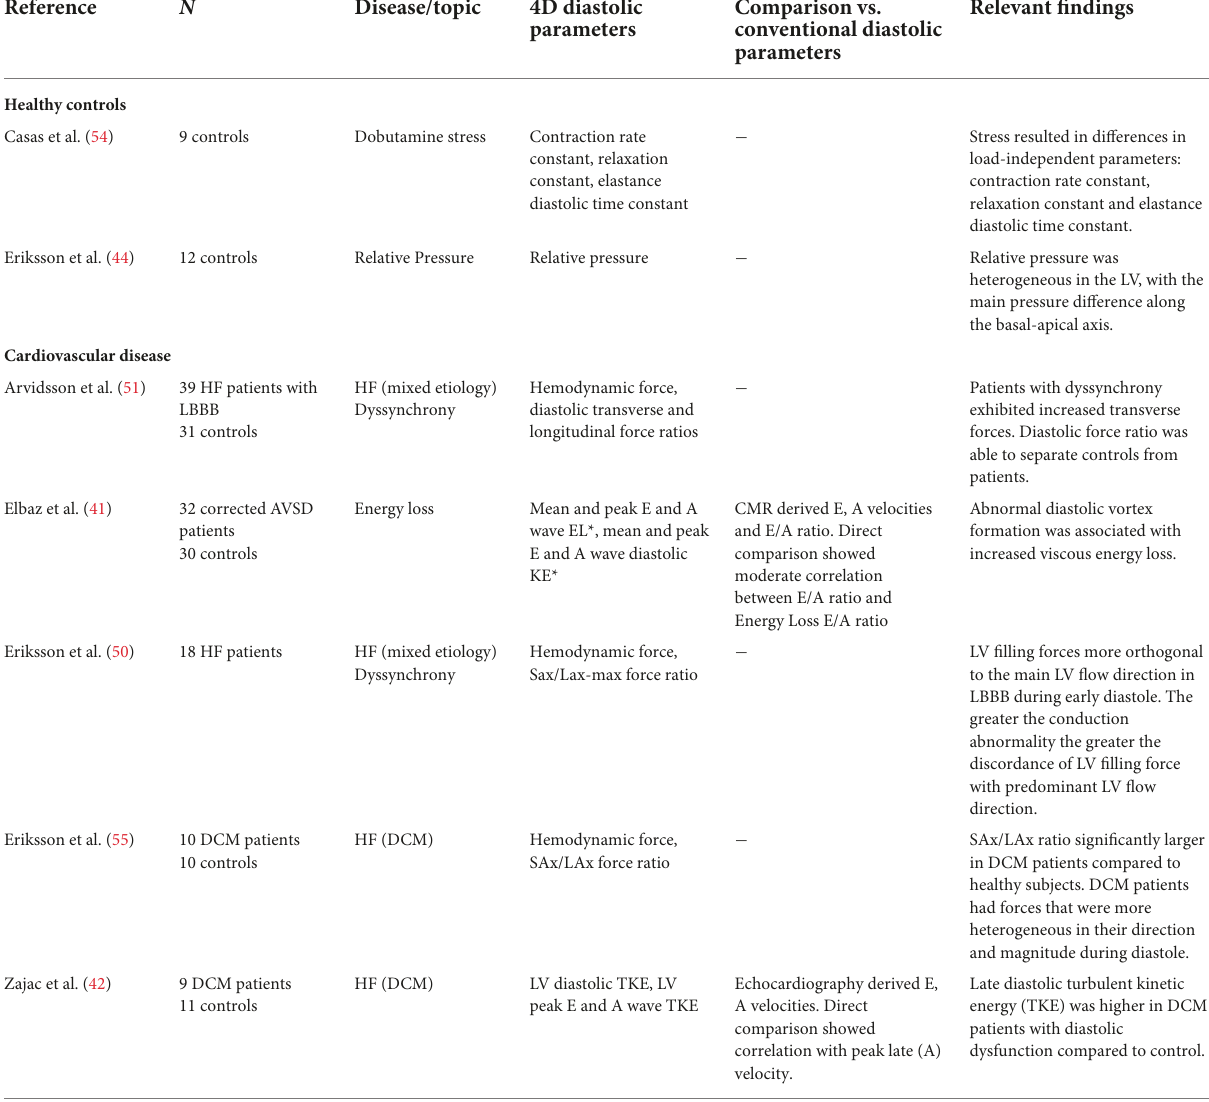
TABLE 2 Four-dimensional flow CMR studies assessing left ventricular diastolic function using other novel 4D global flow